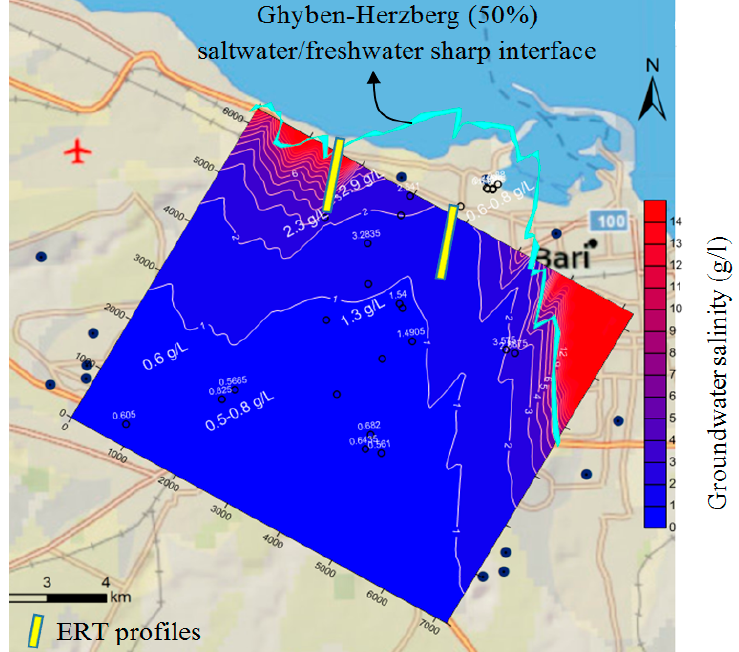
Figure 6. Groundwater salinity map (at a depth of 1.0 m below the water table) given by Ghyben-Herzberg and flow simulation results at the Bari coastal aquifer. Open circles are measured salinities in boreholes.